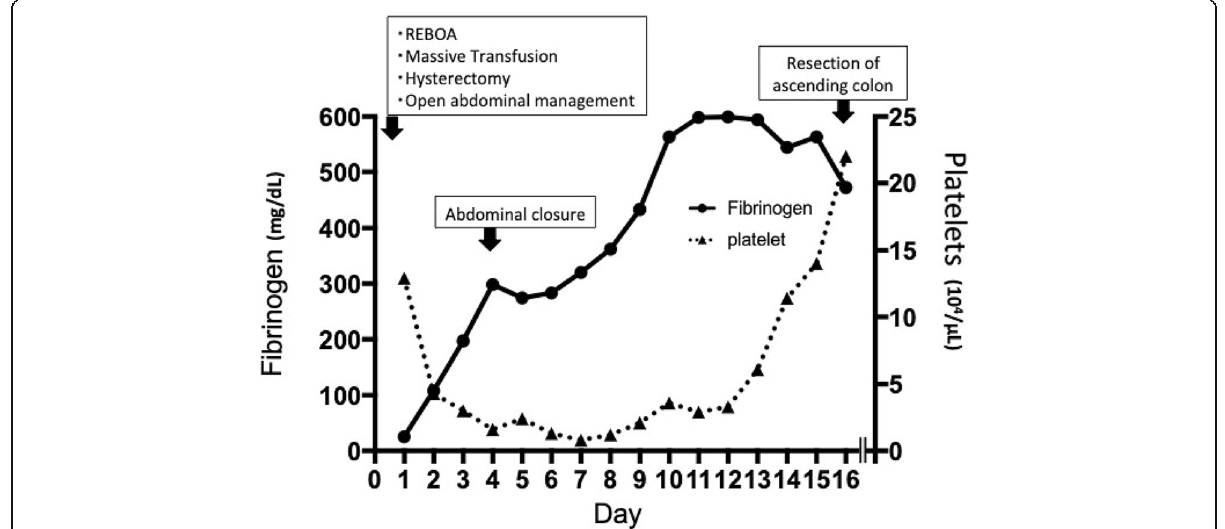
Fig. 2 Time course of platelet counts and fibrinogen level. REBOA resuscitative endovascular balloon occlusion of the